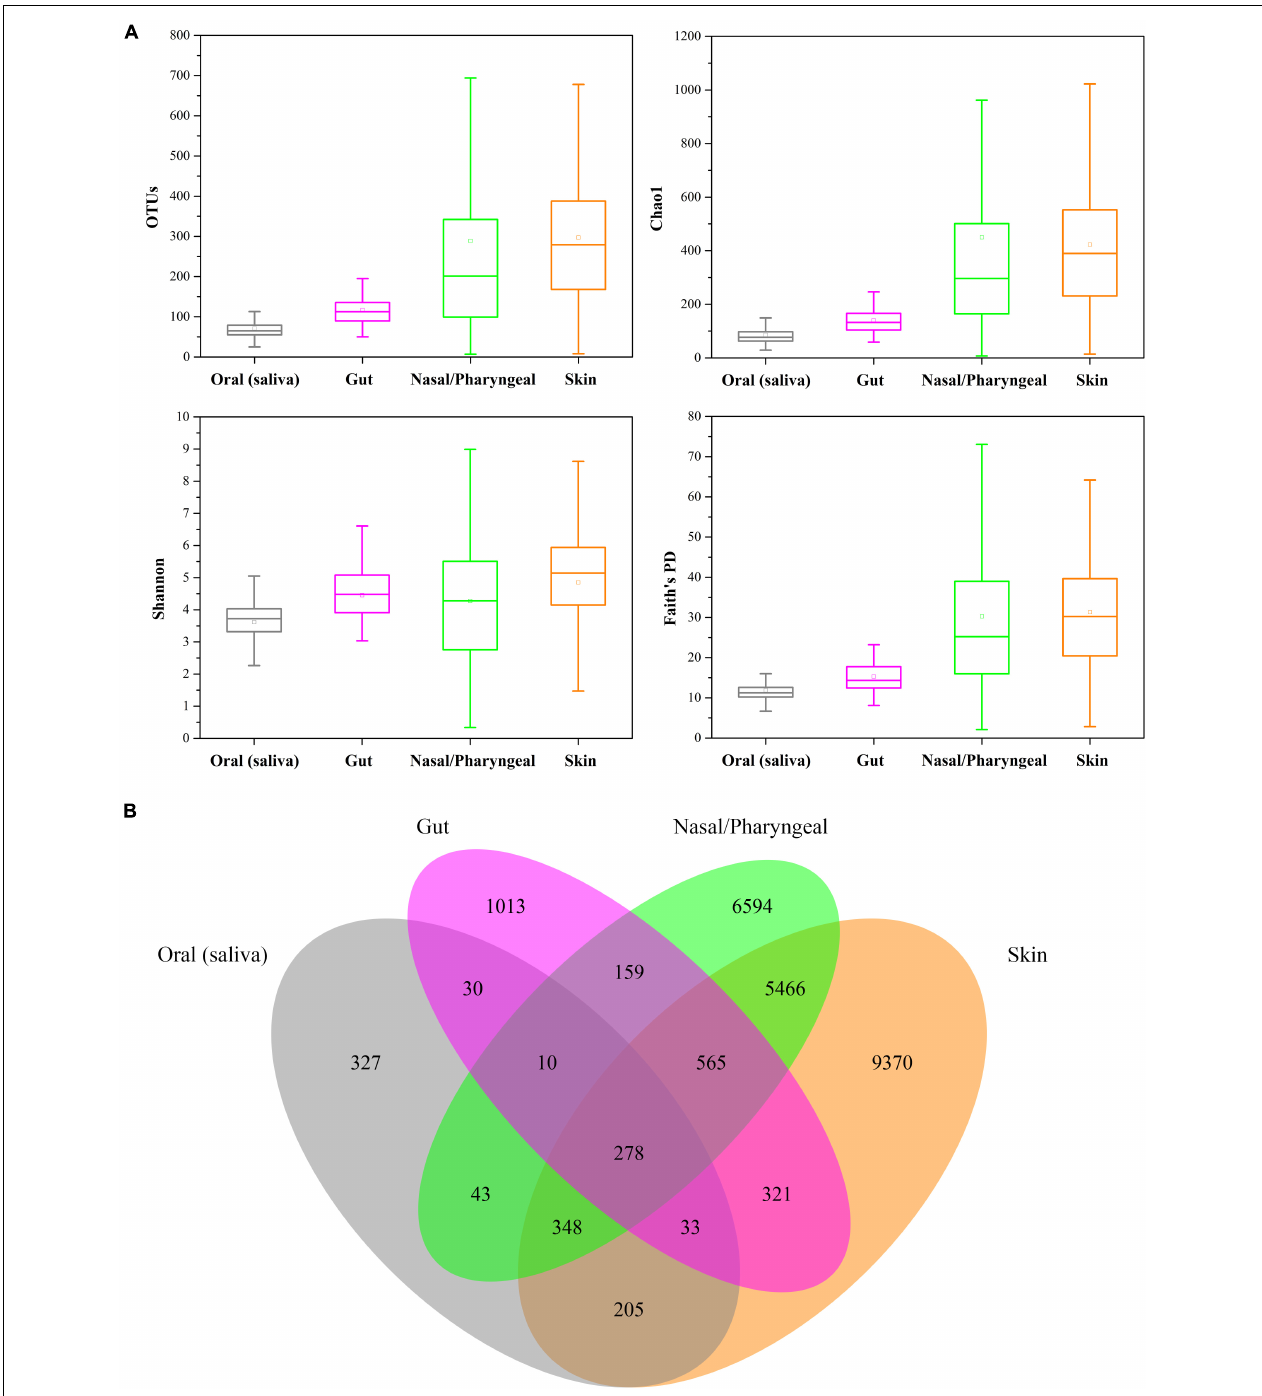
FIGURE 2 | Comparisons of the diversity of human oral saliva, gut, nasal/pharyngeal and skin microbiomes. (A) Comparison of alpha diversity, with diversity calculated sequentially as observed OTU, Shannon index, Chao1 index, and Faith’s PD value. (B) Number of unique and cross-habitat distributed OTUs. Analysis was performed based on 216 gut, 253 nasal/pharyngeal and 346 skin samples from the